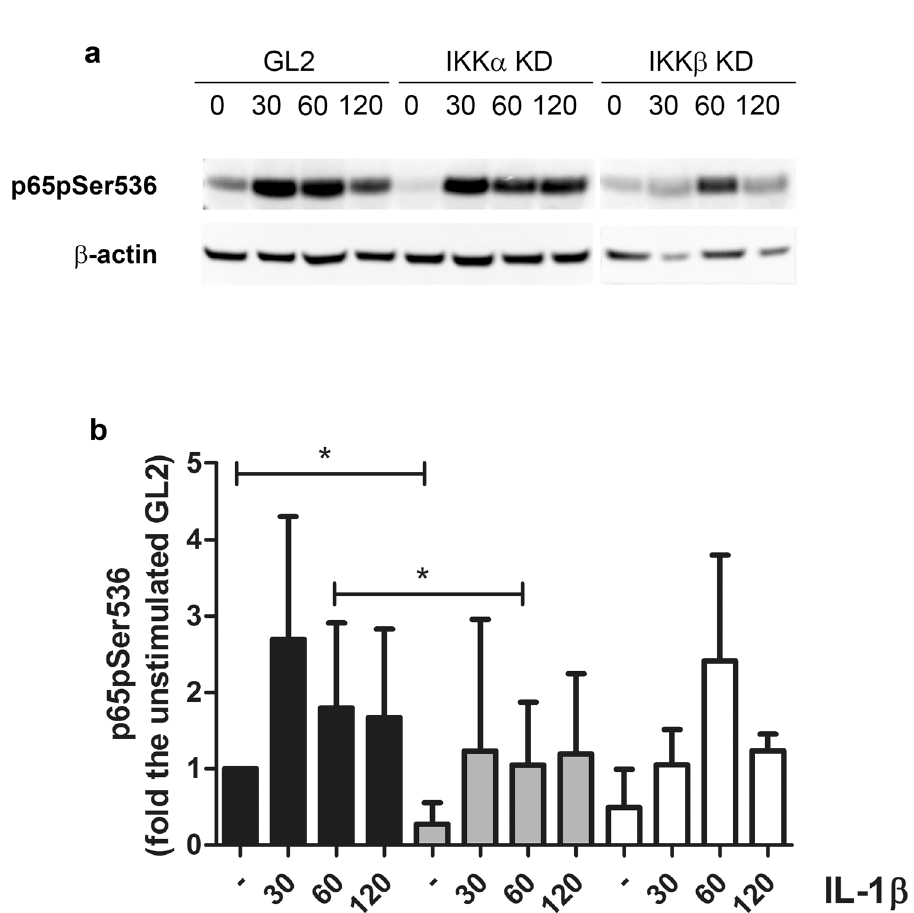
Figure 4. IKK dependency of p65phosphorylation. ( a ) A representative western blot (out of four performed) showing the kinetic of p65 phosphorylation (p65pSer536) in high density cultures of chondrocytes with either the control shRNA (GL2) or with IKKαKD or IKKβ KD. The cultures were either unstimulated (0) or treated with 2 ng/ml IL-1β for 30, 60 or 120 min. At the end of stimulation, the cells were recovered by trypsinization and counted. Total proteins derived from equal cell equivalents were run and blotted. β actin was used as a loading control. ( b ) Data obtained from the four experiments underwent densitometric analysis, and the cumulative results reported as mean ± SD fold increase the level of the control unstimulated GL2. The means of the groups were compared by the Student’s t test. The differences were considered significant when p < 0.05 with *p < 0.05. Different patterns are used for different phenotypes: GL2 black, IKKαKD gray, IKKβKD white. Both the basal and the 60 min p65pSer536 levels were higher in GL2 compared the IKKαKD